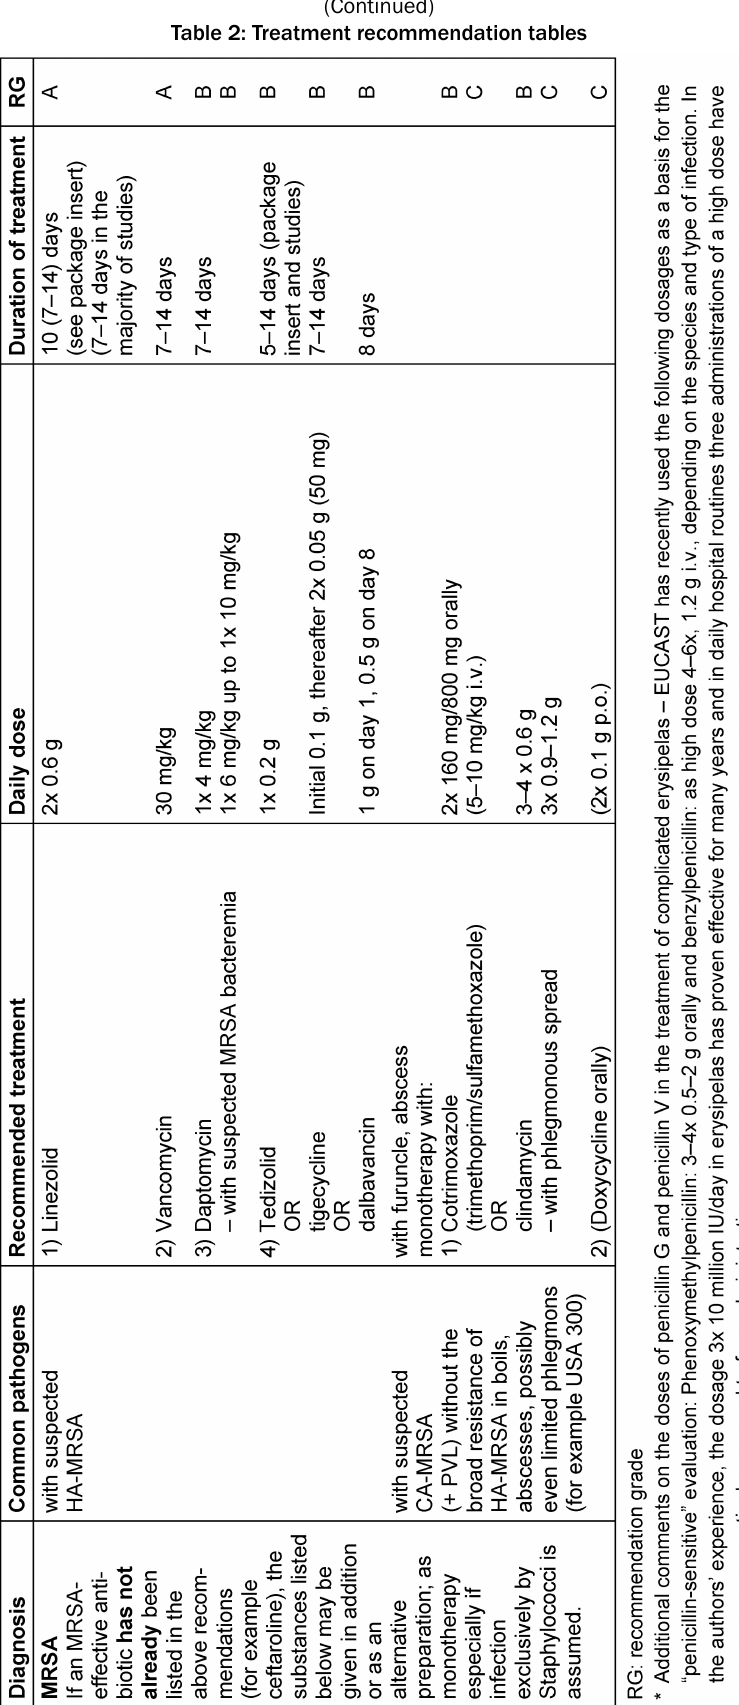
Table 2: Treatment recommendation